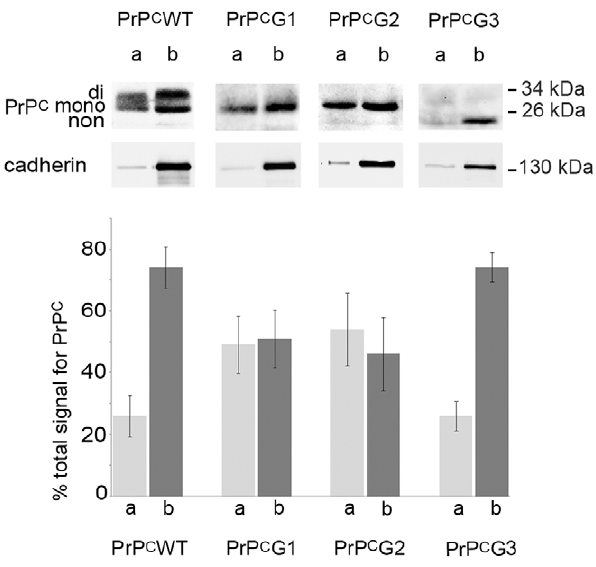
Figure 4. Cell surface biotinylation assay confirms a role of the N-glycans in polarized sorting of PrP C . Cells were grown in Transwells for 4–5 days until fully polarized and labelled with EZ-Link Sulfo-NHS-SS-Biotin either on the apical (a) or the basolateral (b) side. Cells were processed for PrP C (recognized with the 3F4 antibody) and E- cadherin Western blotting in parallel. The graph indicates densitometric evaluation of Western blots of at least 3 independent experiments, expressed as mean percentages 6 SEM apical (a) or basolateral (b) of total protein found, which is set at 100%.